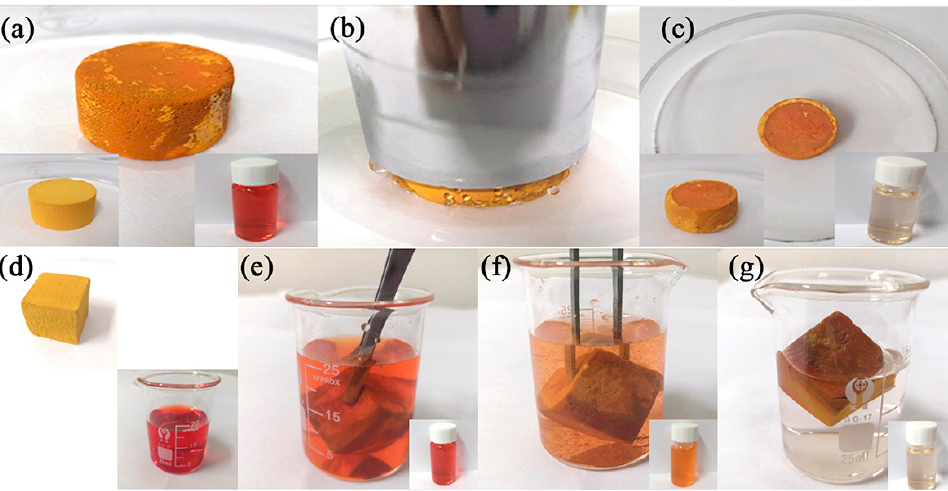
Figure 8. Visualized adsorption behaviour of Congo red dye by PF and ASO-PF. ( a – c ) Adsorption pictures of Congo red dye on PF xerogels; ( d – g ) adsorption pictures of Congo red dye on ASO-PF xerogels.